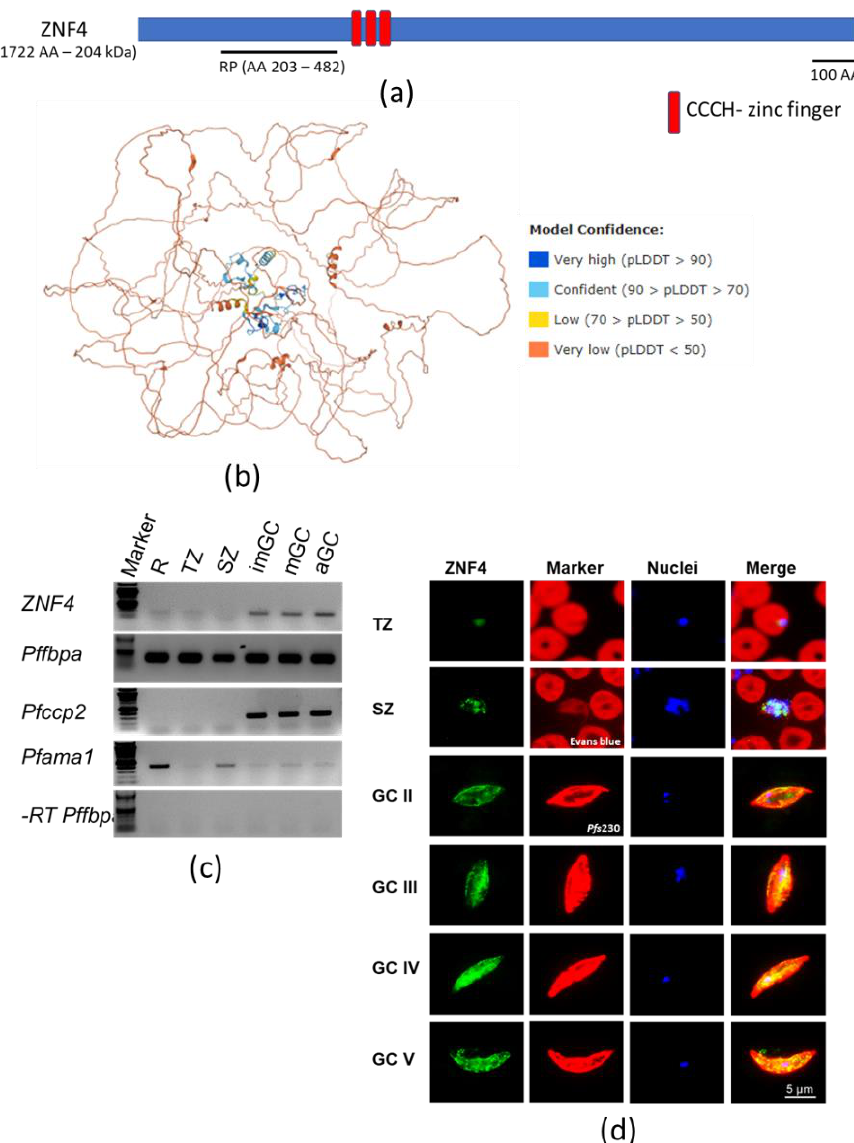
Figure 1. Domain architecture and protein expression of ZNF4: ( a ) Schematic of the ZNF4 domain structure. The 204 kDa protein contains three CCCH zinc finger domains indicated in red. The black line indicates the region used for the generation of the recombinant peptide. ( b ) Predicted 3D structure of ZNF4. The 3D structure of the protein was predicted using AlphaFold (https://alphafold.ebi.ac.uk/ accessed on 12 January 2022) [40,41]. Colours indicate the confidence level of prediction which ranged from blue (very high confidence) to orange (very low confidence). ( c ) Transcript expression of ZNF4 in the blood stages of P. falciparum . Complementary DNA was synthesized from rings (R), trophozoites (TZ), schizonts (SZ), immature (imGC), mature (mGC), and gametocytes at 30 min post-activation (aGC) and subjected to diagnostic PCR using ZNF4-specific primers. The expression levels of Pfama1 and Pfccp2 were used to verify asexual blood stage and gametocyte-specific expression. Samples lacking reverse transcriptase (-RT) were used as controls to check for any contamination with gDNA. Pffbpa was used as a loading control. ( d ) Localization of ZNF4 in different blood stages of P. falciparum . Anti-ZNF4 was used to immunolabel fixed samples of trophozoites (TZ), schizonts (SZ), and gametocytes (GC stage II to V) as well as of activated gametocytes (aGC) at 30 min post-activation (green). Asexual blood stages (trophozoites and schizonts) were visualized by labelling with Evans blue and gametocytes were visualized by using rabbit anti-Pfs230 (red); nuclei were highlighted by Hoechst nuclear stain 33342 (blue). Bar, 5 µm.